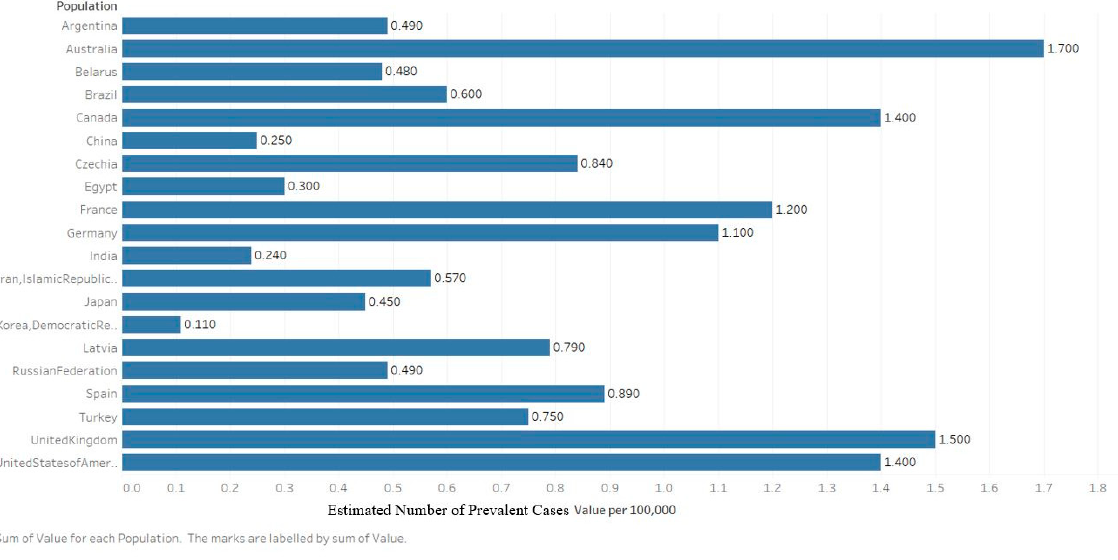
Figure 4. Graph showing the estimated number of prevalent cases (5 year) as a population in 2018 of multiple myeloma for both sexes, ages 0–74. Created with Tableau 2019.2 Data obtained from GLOBOCAN 2018 [7].